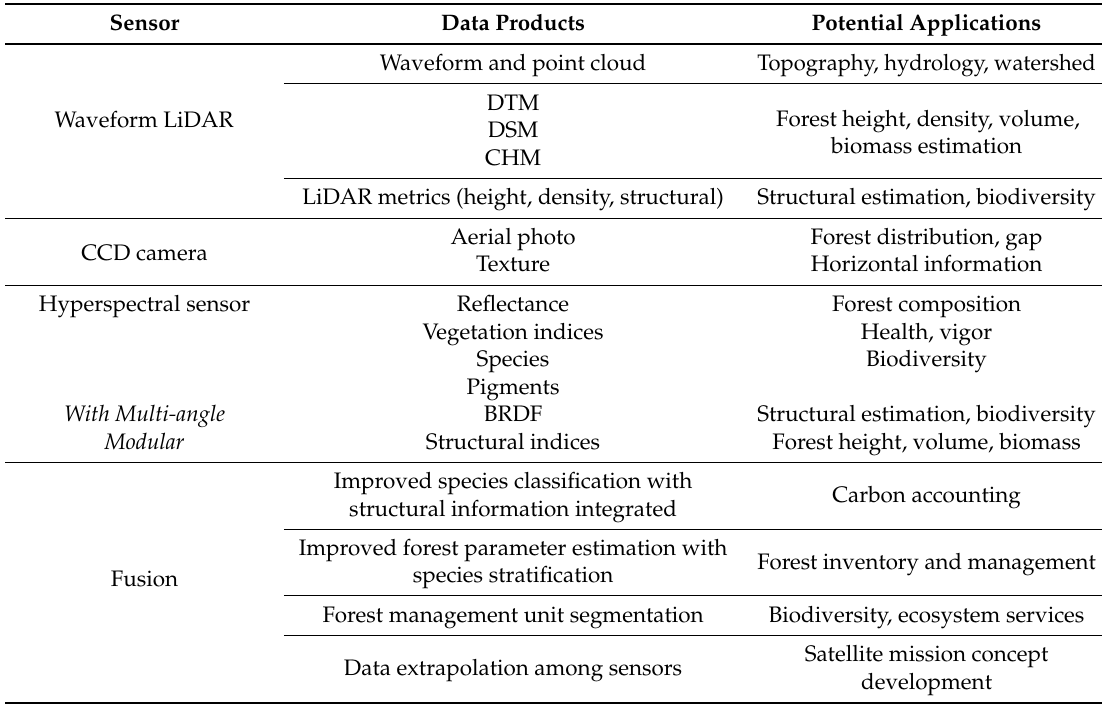
Table 3. Potential forest applications of data from LiCHy